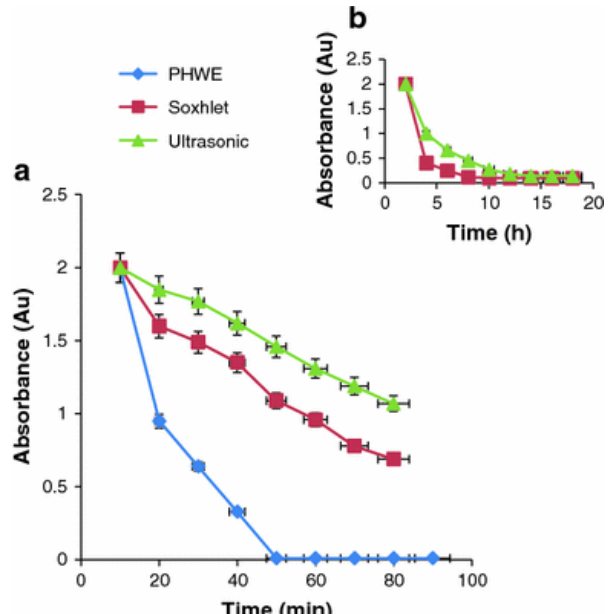
Figure 8. Absorbance of chlorophyll in each washing at: ( a ) 10 min intervals for the three extraction methods; and ( b ) at 2 h intervals for Soxhlet and ultrasound-assisted extraction. Reprinted from Batlokwa et al. [88] with permission from